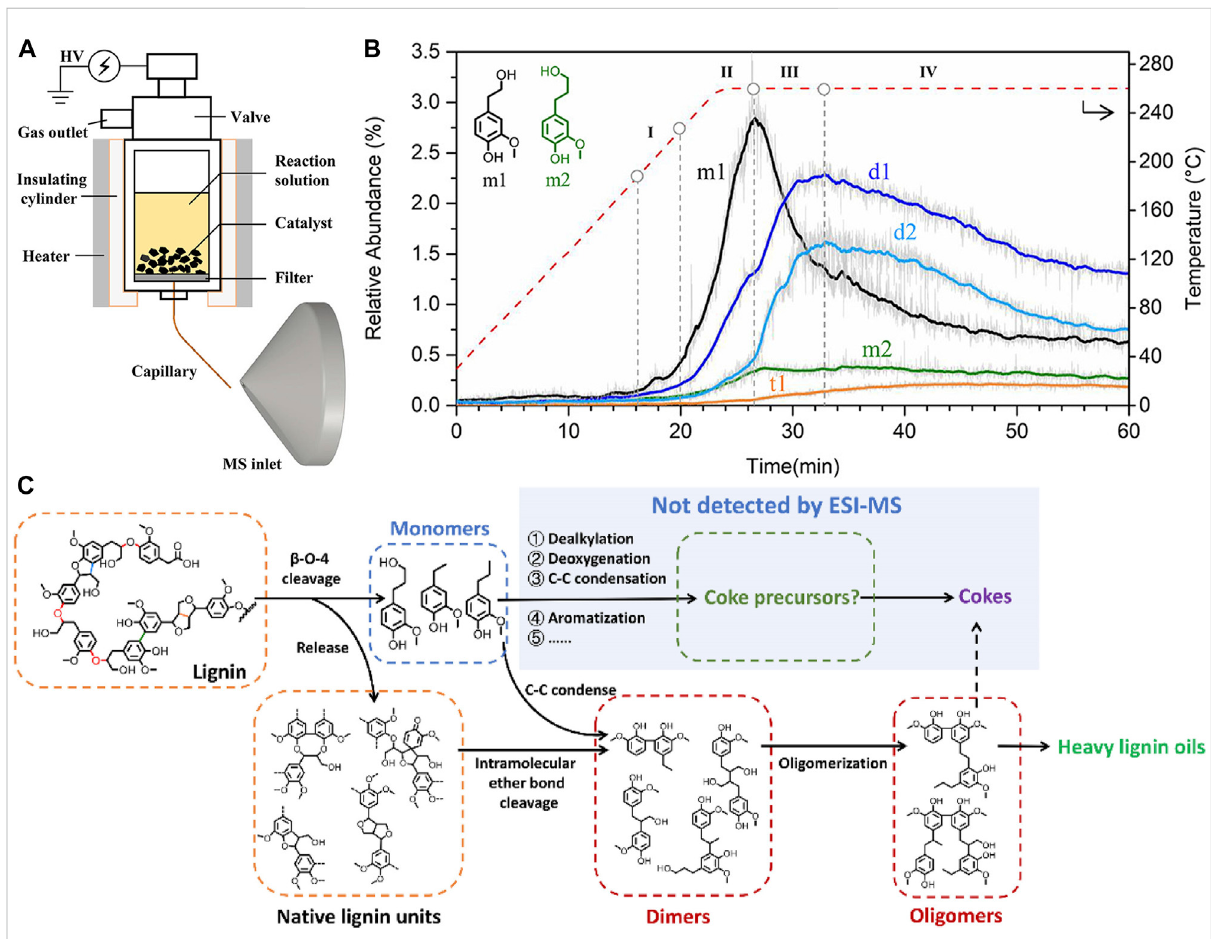
FIGURE 2 (A) AsketchofR-ESIMS.ReprintedfromCuietal.(2021a),withpermissionfromAmericanChemicalSociety(Copyright2021). (B) Theevolution of typical phenolic products with different polymerization during the online liquid-phase detection,where m1 and m2 refer to two representative monomers, d1 and d2 are two dimers, and t1 is a trimer. Reprinted from Cui et al. (2021a), with permission from American Chemical